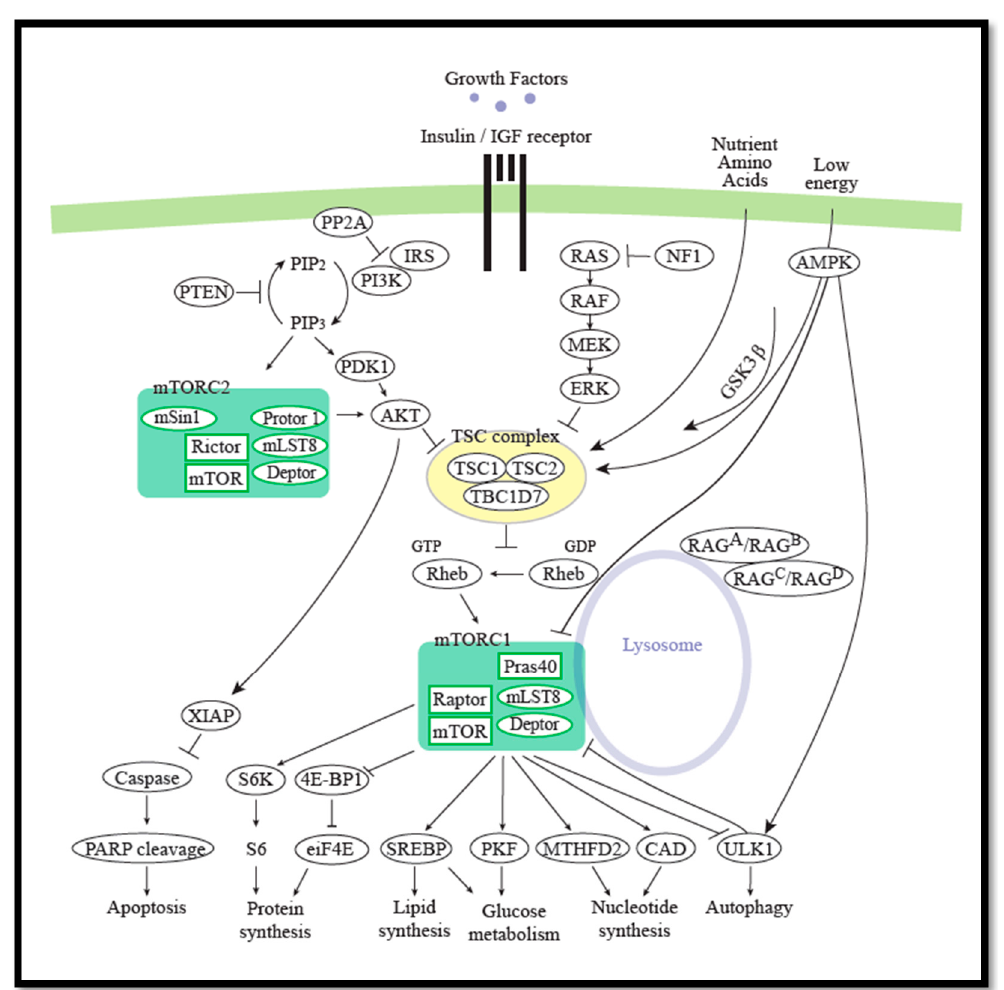
Figure 2. The mTOR pathway. mTOR is a member of the mTORC1 and the mTORC2 complexes. mTORC1 is composed of mTOR, Deptor, mLST8, RAPTOR, and PRAS40. mTORC2 is composed of mTOR, Deptor, mLST8, RICTOR, mSIN1, and PROTOR1. The tumor-suppressor TSC1 / 2 complex negatively regulates mTORC1 by inhibiting the protein RHEB. P13K, the RAS–RAF–MEK–ERK (MAPK) pathway, PTEN, LKB1, and NF1 are all members of the mTORC1 signaling pathway. Activation of mTORC1 begins when, e.g., growth factors activate PI3K. PI3K activates AKT1, which inactivates the TSC1 / 2 complex. RHEB activates mTORC1, which regulates the activity of S6K and 4E-BP1. The lysosomal localization of active mTORC1 is dependent on Rag GTPases. mTORC1 regulates nucleotide synthesis, glucose metabolism, lipid synthesis, and protein synthesis positively and regulates autophagy negatively. AMPK regulates mTORC1 negatively. Apoptosis is negatively regulated by AKT. See text for further details.